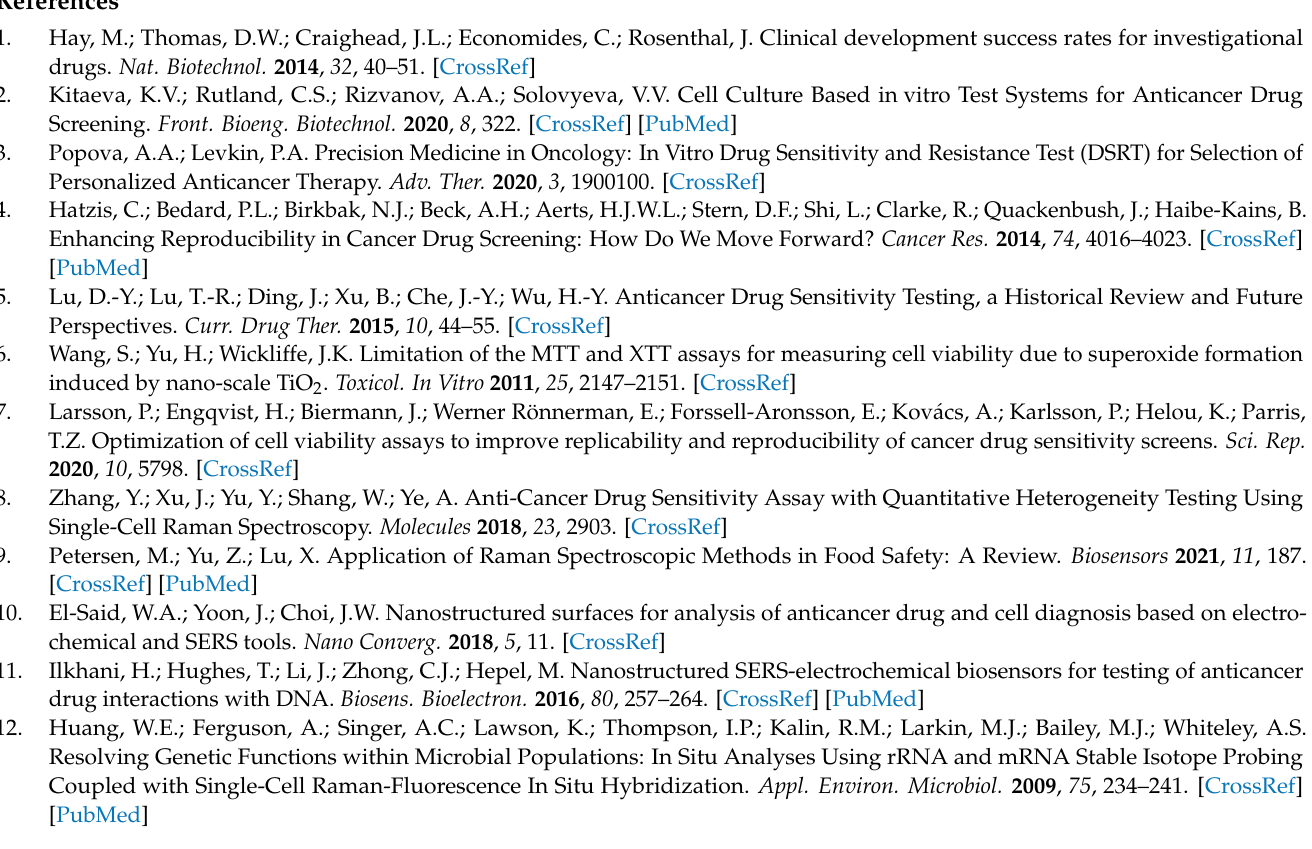
Figure S2. Changes in Raman intensities for nucleic acid (781 cm − 1 ), protein (1240 cm − 1 ), protein and lipids (1450 cm − 1 ), and carbon–deuterium bond (2170 cm − 1 ) of HCC827 and MCF-7 cell lines under different D2O concentrations. Figure S3. Illustration of deuterium from D 2 O incorporation to biomolecules by active cells. Figure S4. Bright-field microscopic images (50 × objective) of MCF-7 cells treated with D 2 O for 12 h. Figure S5. Bright-field microscopic images (50 × objective) of MCF-7 cells treated with D 2 O for 36 h. Table S1. The specifications of the confocal Raman spectrometer. Table S2. The difference of viability of cancer cells at different D 2 O/H 2 O concentrations. Table S3. IC 20 , IC 30 , and IC 40 of different chemotherapy drugs. Table S4. Sensitivity, specificity, and accuracy of the criterions IC 20 , IC 30 , and IC 40